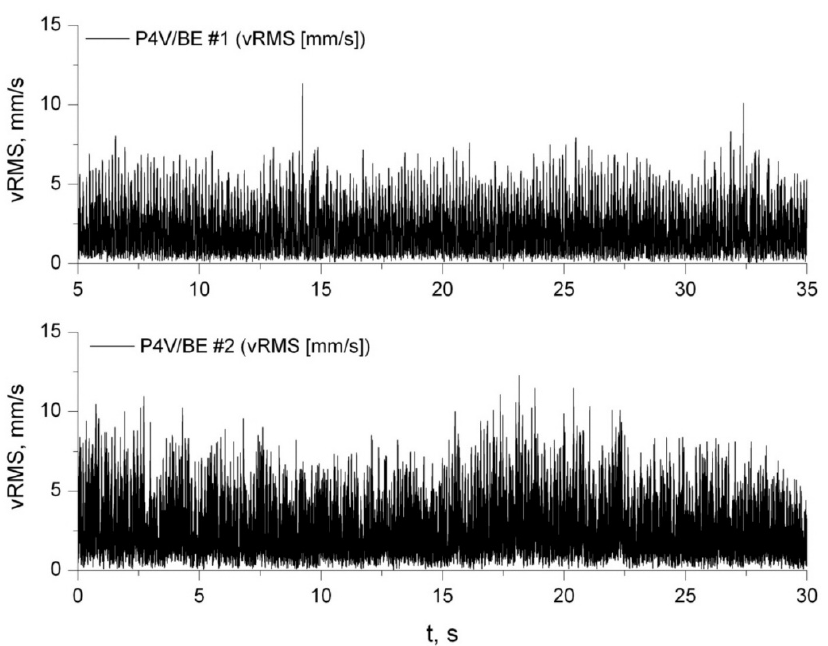
Figure 4. Time waveform of vibration velocity in the vertical direction at point P4 (on the bearings on the left-hand-side of output shafts) in bucket elevators BE#1 ( upper diagram ) and BE#2 ( lower diagram ).